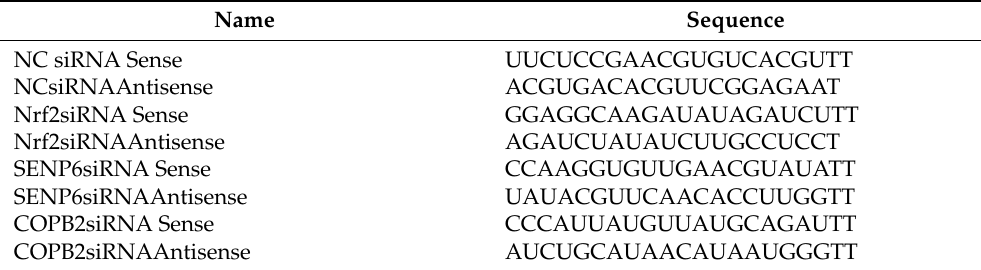
Table 2. Sequences of siRNA in this study (5 (cid:48) → 3 (cid:48) ).